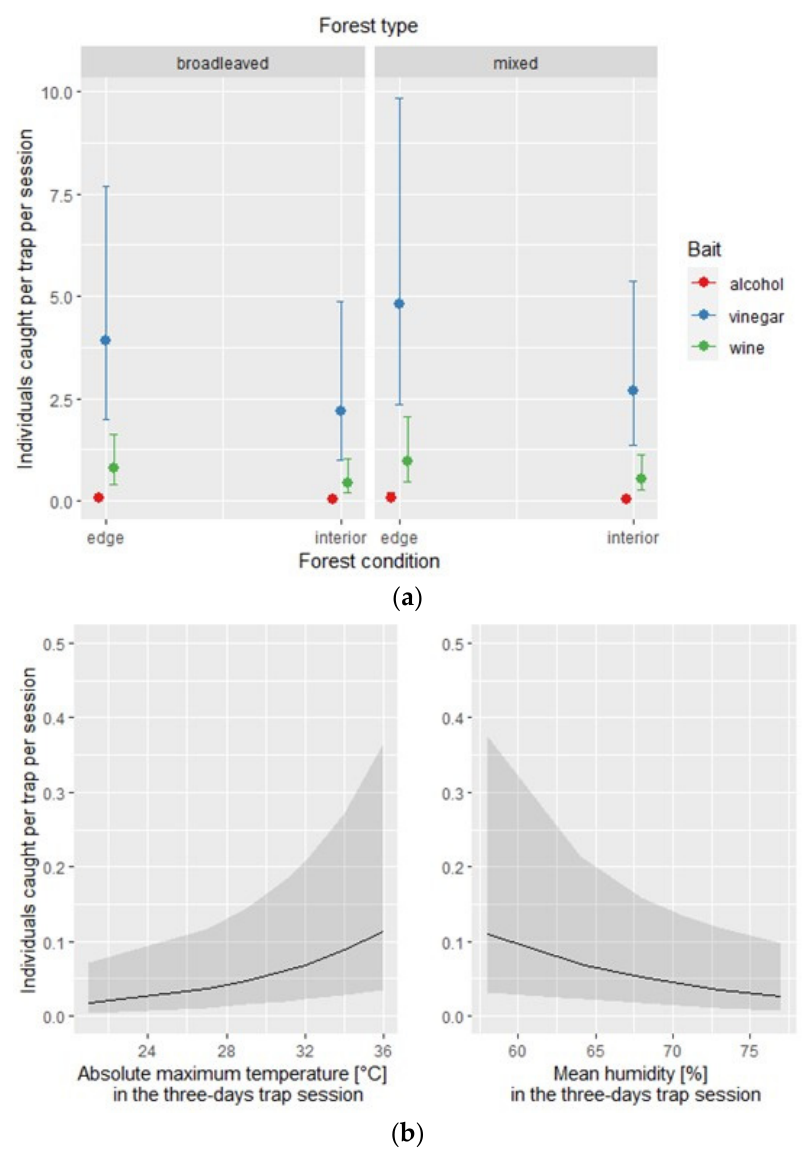
Figure 3. Exotic species: effect of the covariates of the negative binomial regression model affecting the number of individuals caught by each of the three traps per site and per session; ( a ) conditional effect of habitat covariates (forest type: broadleaved vs. mixed; forest condition: edge vs. interior); ( b ) main effect of meteorological covariates. Table 4. Exotic species. Effectiveness of baits in attracting individuals of all species pooled to- gether, accounting for the effects of habitat and meteorological covariates considered in the nega- tive binomial regression model.